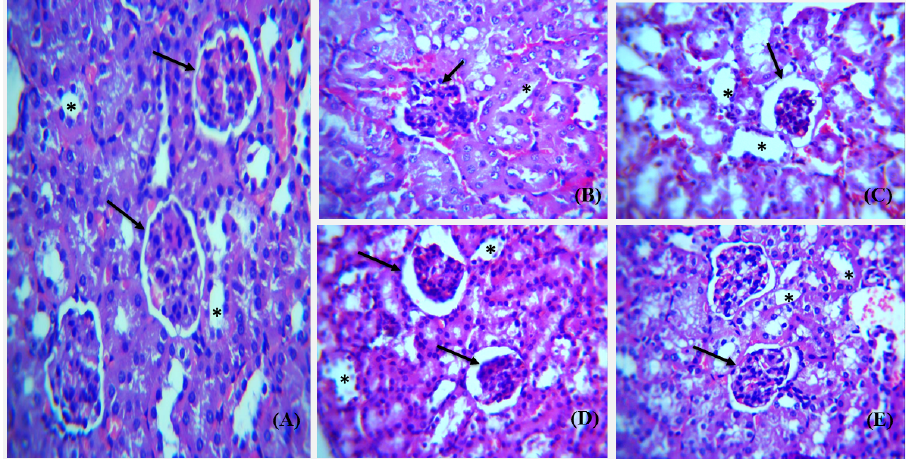
Figure 20. Photomicrograph showing Hematoxylin and Eosin stained (H&E) (×40) sections of kidney with asterisk showing kidney tubules and arrow showing glomerulus. ( A ) Control group with regular shape of glomerulus and distinguishable collecting duct and renal tubule. ( B ) Untreated diabetic group showing irregular renal cells distribution, tubules dilation, and glomerulosclerosis. ( C ) The diabetic metformin-treated group shows somewhat normal appearance of tubules and intact glomerular boundary when compared to the diabetic group. ( D ) Diabetic-AgNPs treated (5 mg/kg) group showing restoration of glomerular boundary and intact kidney tubules. ( E ) Diabetic AgNP (10 mg/kg) treated group show more reno-protective activity as compared to the standard metformin with complete restoration of glomerulus and renal